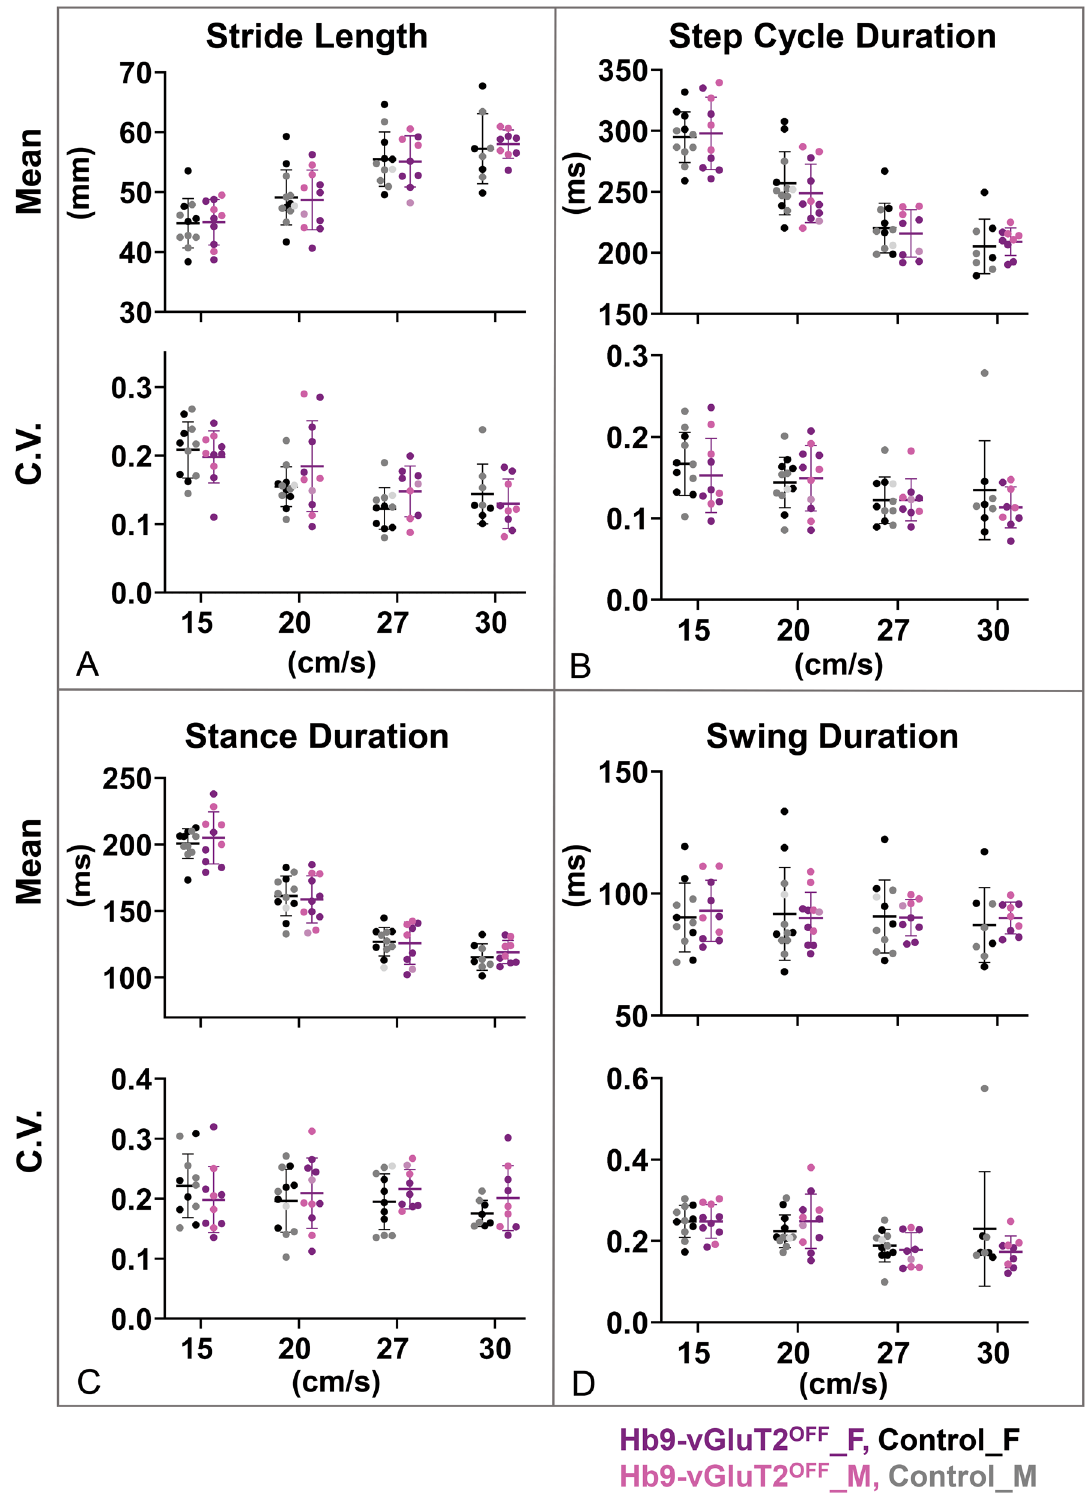
Figure 6. The timing of locomotion in Hb9-vGluT2 OFF mice is similar to that of controls. ( A ) Stride lengths (upper panel) and their coefficients of variation (lower panel) were the same in the mutant and control mice. ( B ) Similarly, no difference was observed in cycle durations (upper panel) or their coefficients of variation (lower panel). ( C ) Stance durations were also similar (upper panel), as were their coefficients of variation (lower panel). ( D ) There was no difference in swing duration (upper panel). The coefficients of variation were also the same at all speeds (lower panel). Number of mice used at the 4 speeds for the control group (total 12) were 11 (5 females), 12 (5 females + 1 not specified), 11 (5 females + 1 not specified), and 8 (4 females), and for the Hb9-vGluT2 OFF group (total 11) were 10 (6 females), 11 (6 females + 1 not specified), 9 (5 females + 1 not specified), and 9 (5 females). Details of statistics are in Tables 2 and 4. Black: Control Female; Gray: Control Male; Light grey: Control sex not specified; Purple: Hb9-vGluT2 OFF Female; Pink: Hb9- vGluT2 OFF Male; Lavender: Hb9-vGluT2 OFF sex not